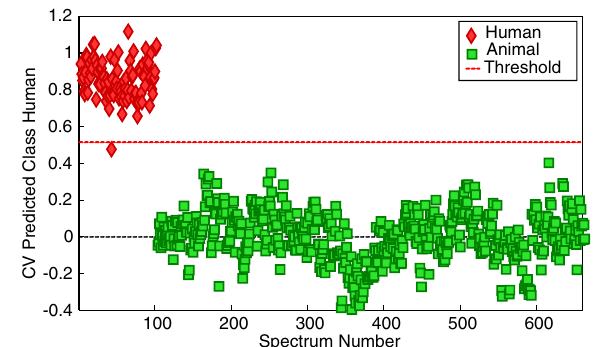
Table 1 Assignment of the infrared bands in human blood.